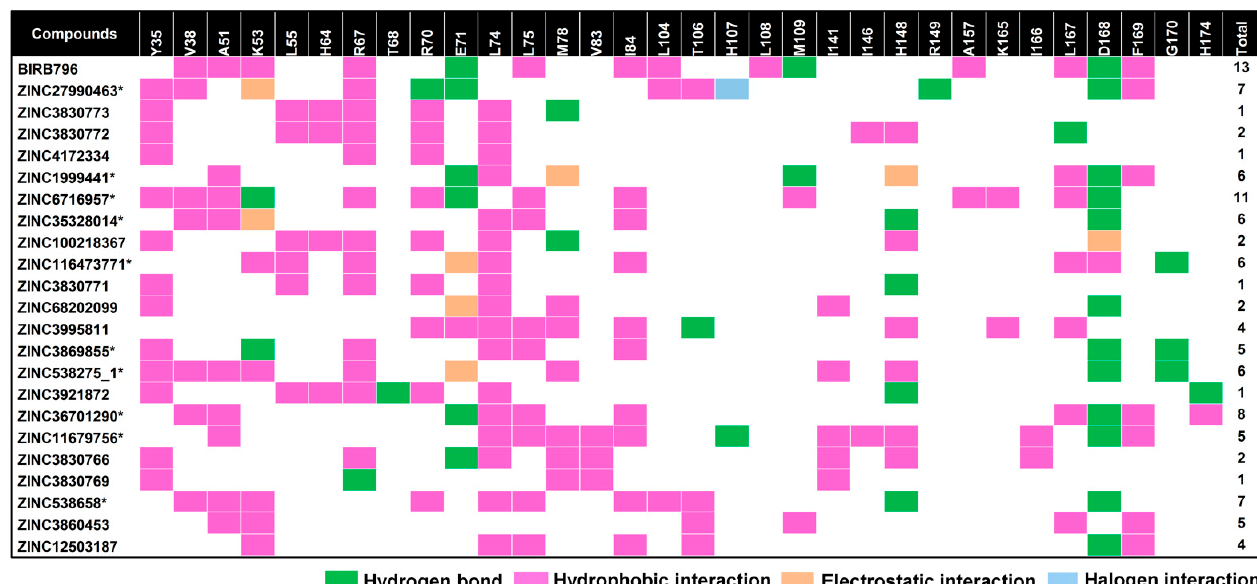
Figure 4. Map of intermolecular interactions of BIRB796 and all 22 screened compounds as well as total features sharing interactions with BIRB796. Each type of noncovalent interaction was also illustrated in different colors. It is worth noting that these occurred interactions were based upon the best docked conformation and visualized by Accelrys Discovery Studio 2.5. * The compounds selected to run MD simulations.